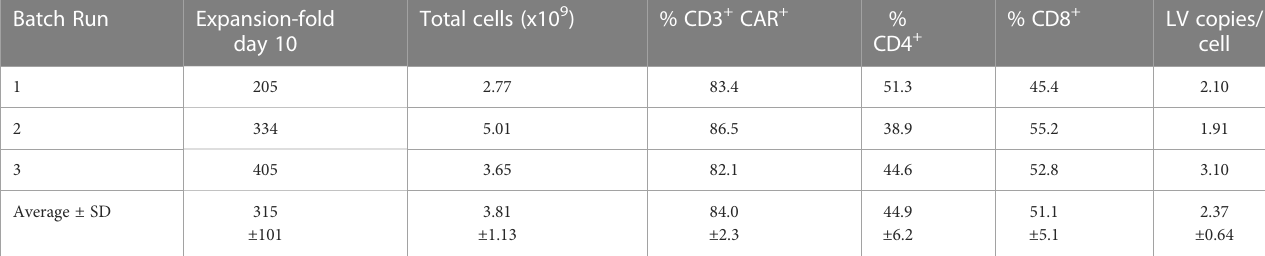
TABLE 2 Validation of gp350CAR-T cell manufacturing after production and testing of three independent and consecutive batch runs. Batch Run